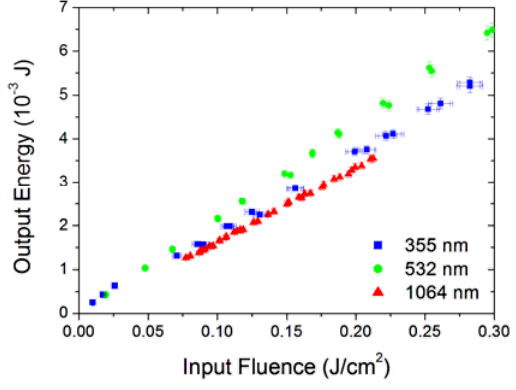
Figure A1. Linearity of the base fluid (water + surfactant).